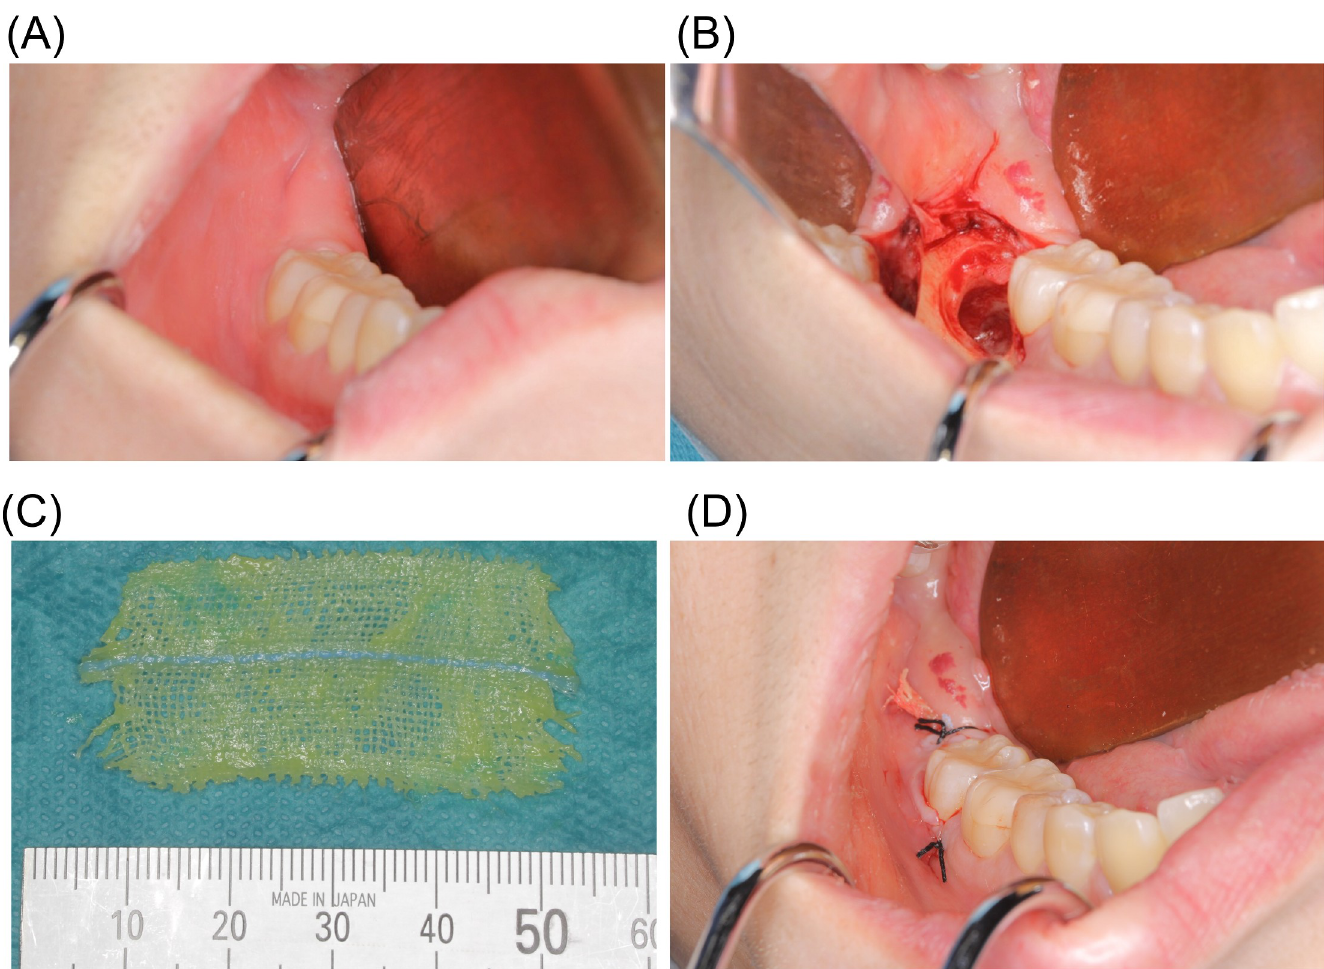
Fig 1. Surgical procedure and application of gauze coated with oxytetracycline-hydrocortisone ointment. (A) Preoperative view before lower third molar extraction under local anesthesia. (B) View after tooth extraction, curettage of the extraction socket, and cleansing with saline. (C) 5 x 2 cm piece of gauze coated with oxytetracycline-hydrocortisone ointment applied to the gauze-insertion group. (D) View after inserting gauze into socket and suturing.